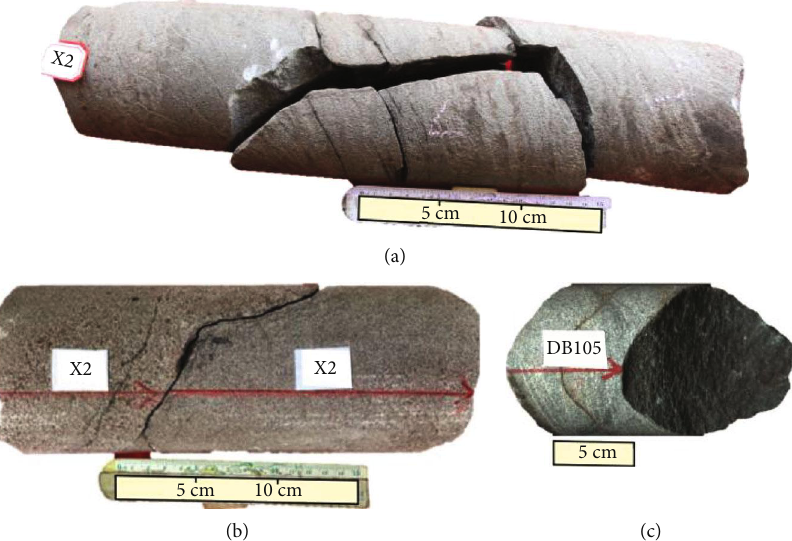
Figure 7: Typical fractures in drilling cores. (a) Well X2, 5110.2 ~ 5110.6m; the formation of Jurassic; it can be seen as high angle shear fracture and a group of low angle interlayer fractures; the interlayer fractures are fi lled with argillaceous and carbonaceous materials. (b) Well X2, 5122.2 ~ 5122.4m; Ahe formation of Jurassic, a curved shear fracture with medium-high angle, un fi lled. (c) Well DB105, 4759m ~ 4767.5m, Ahe formation of Jurassic, a group of parallel low angle fractures is developed, the coal is fully fi lled, and the core is fractured along the